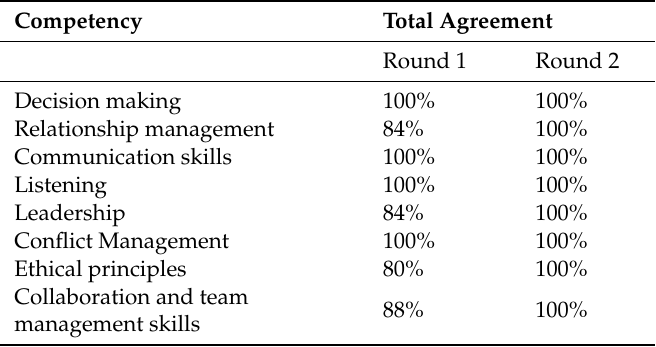
Table 2. Core of competencies.